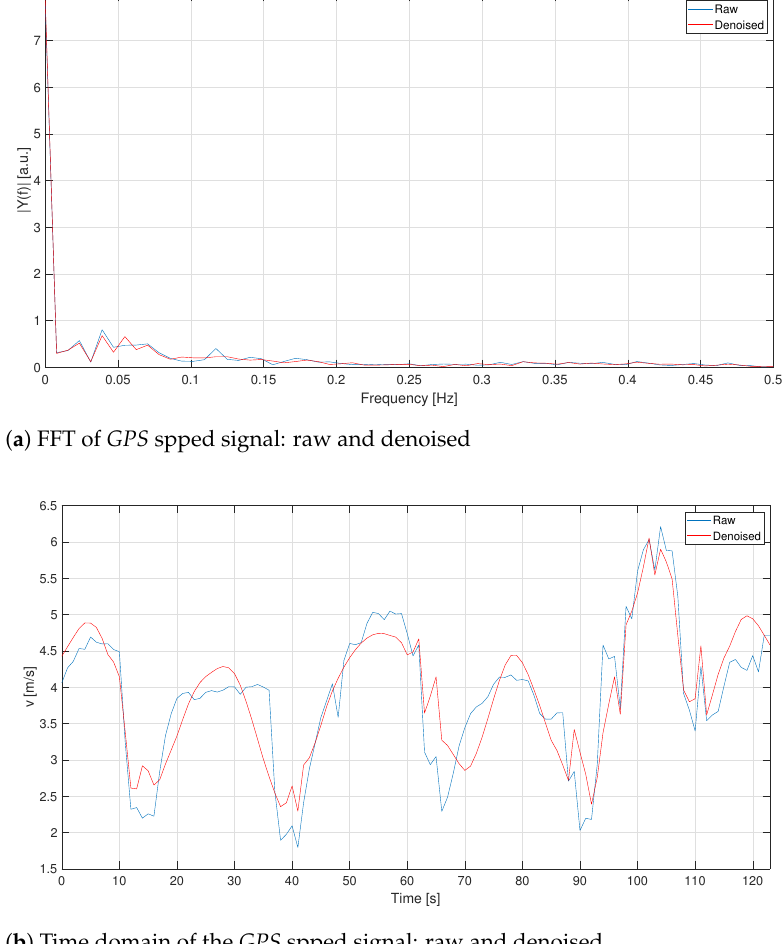
Figure 5. C1—Comparison between raw and denoised signals for the